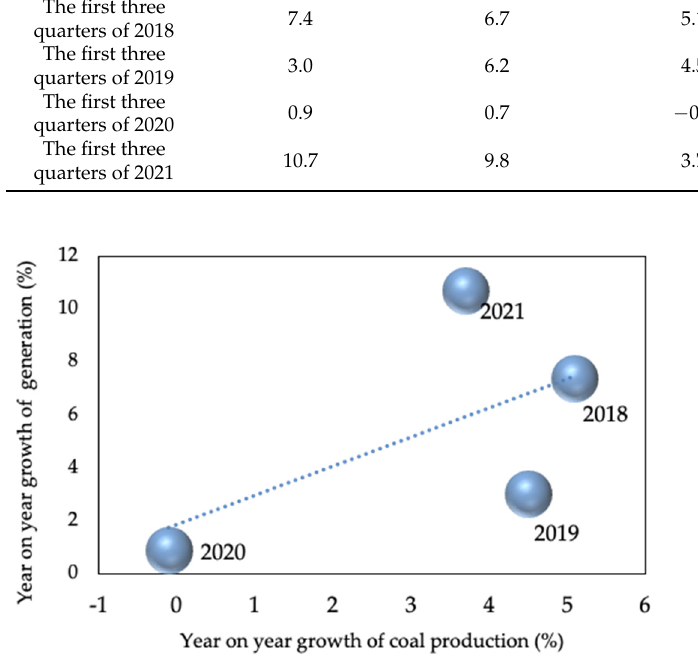
Figure 2. Comparative relationship between the growth of power generation and coal production.